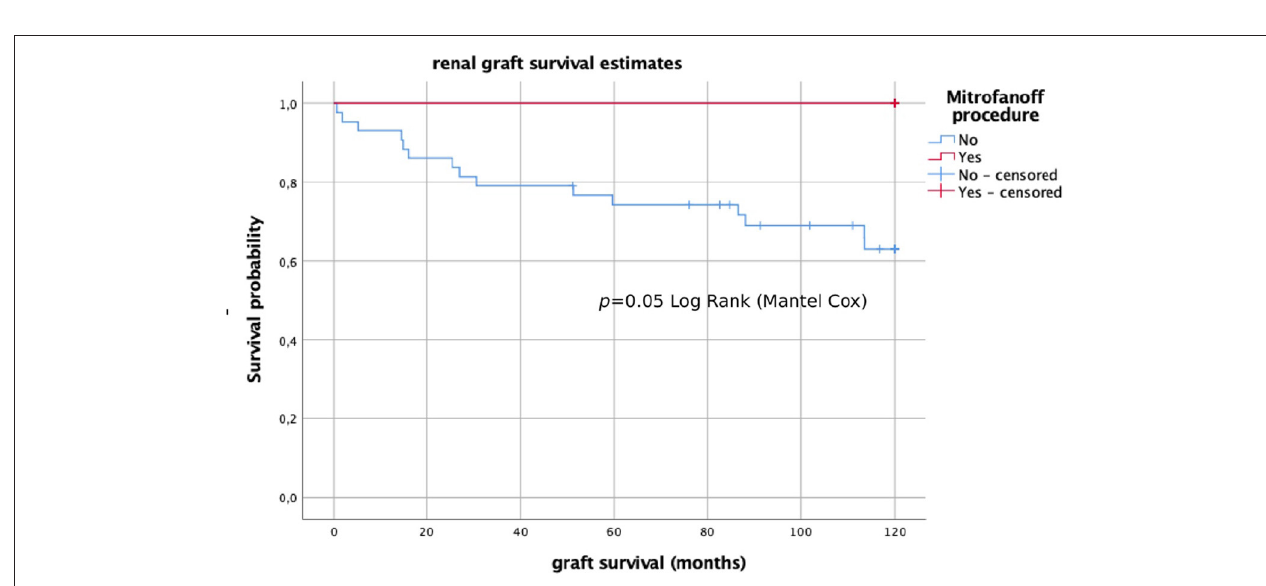
FIGURE 2 | Long-term graft survival (Kaplan–Meier analysis) in patients who did and did not undergo the Mitrofanoff procedure.